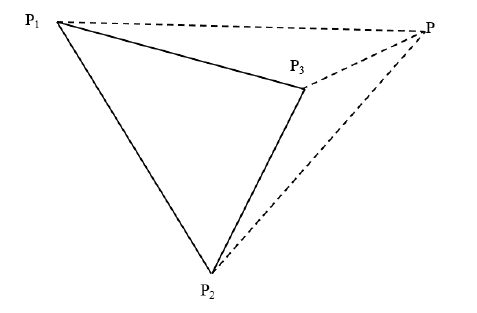
Figure 3: Two edges are